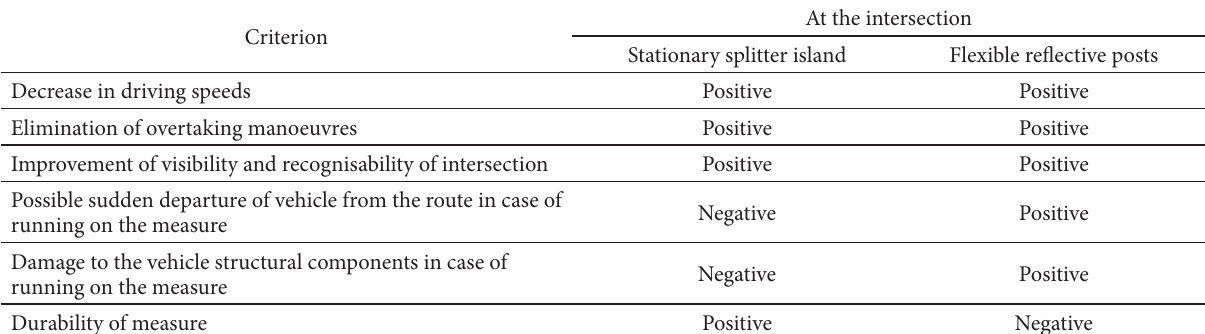
Table 4. The impact of analogical measures on the change in traffic indices